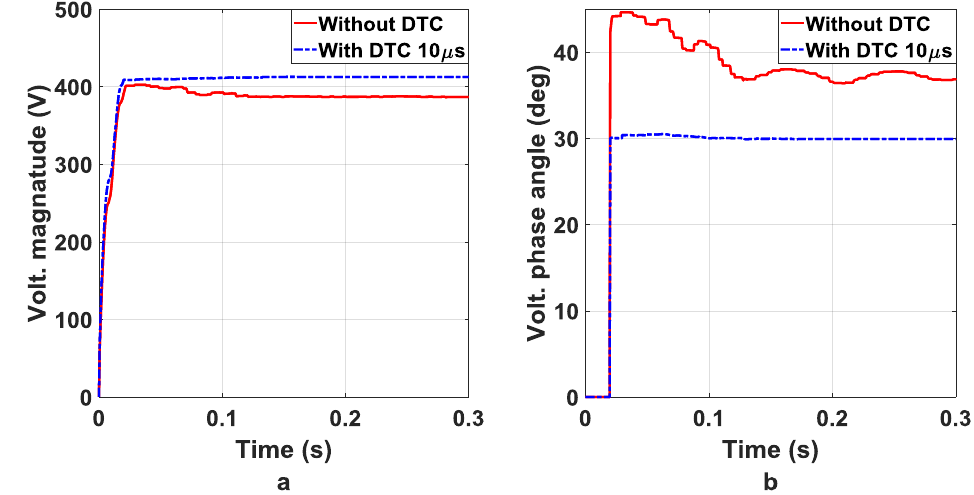
Figure 11. Without / with 10 µ s DTC ( a ) fundamental voltage ( V a ) magnitude ( b ) fundamental voltage Figure 11. Without/with 10 𝜇 s DTC ( a ) fundamental voltage ( 𝑉 𝑎 ) magnitude ( b ) fundamental voltage